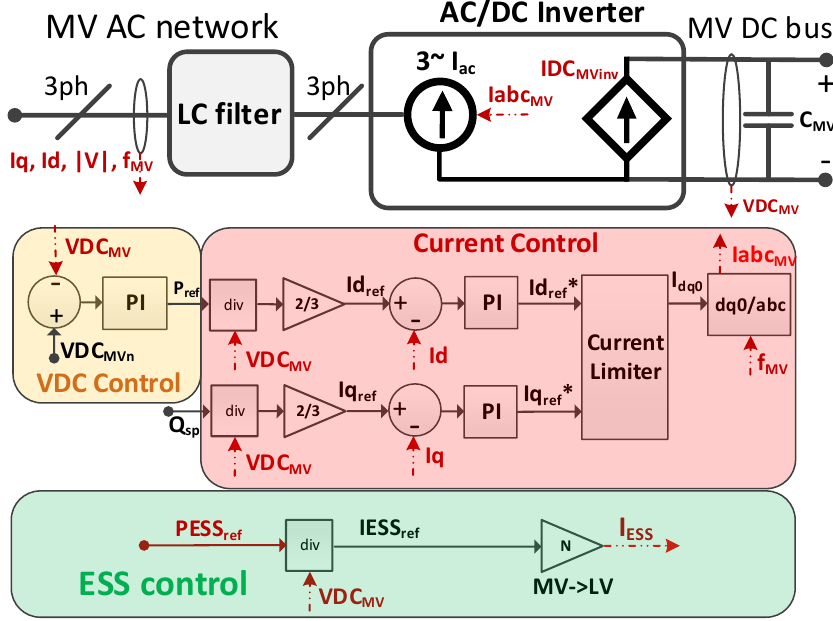
Figure 3. Smart Transformer’s (ST) Medium Voltage Inverter model and respective control